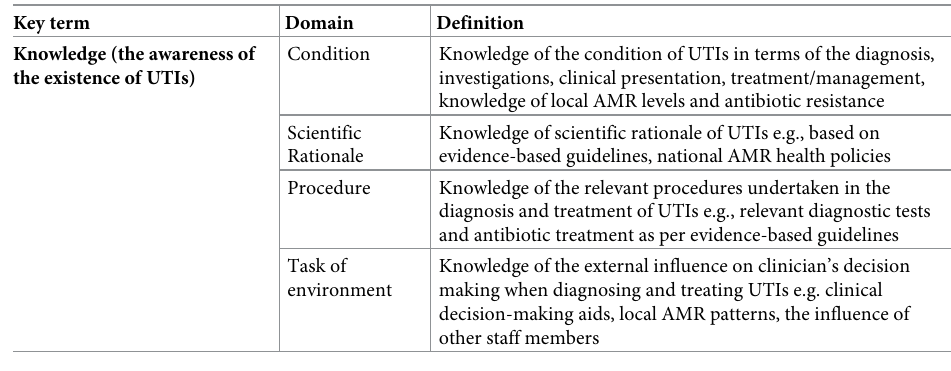
Table 2. Conceptualisation of knowledge.